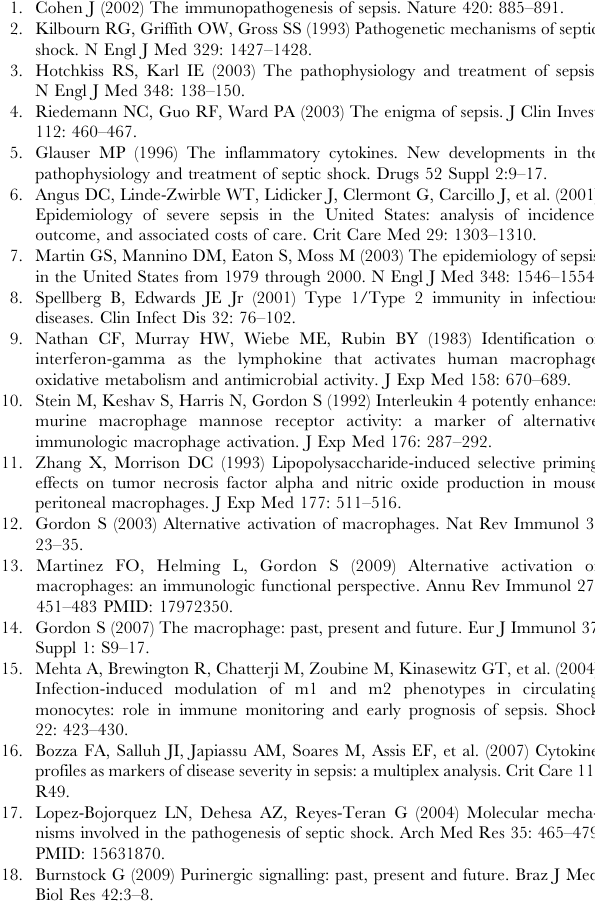
Figure S2 P2Y11 receptor antagonist NF157 suppressed production of IL-6 from peritoneal macrophages. Perito- neal macrophages were pretreated with NF449 (10 m M), NF157 (50 m M), or KH7 (100 m M) for 30 min. At 24 h after LPS (10 m g/ mL) ( A ) or ATP (100 m M) ( B ) stimulation, supernatants were collected and the concentration of IL-6 was measured by ELISA (n= 5). Each value represents the mean 6 SE. Significant differences between the positive control group (LPS) and the indicated group are indicated by *(p , 0.05) and ***(p , 0.001). (TIF) Figure S3 P2X1 antagonist NF449 did not suppressed the increase in serum levels of cytokines in LPS-treated mice. ( A – D ) Male C57BL/6 mice at 6 weeks of age were given LPS (400 m g/head i.p.). NF449 (100 m L of 100 m M) were administered intraperitoneally at 2 h before LPS was injected. Blood samples were collected at 6 h after LPS injection. Serum levels of IL-1ß, IL-6, IL-12 and TNF-alpha were determined as described in Materials and Methods . Each value represents the mean 6 SE (n=